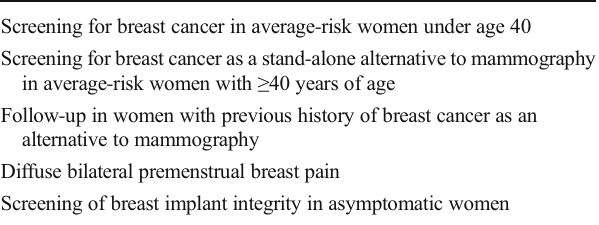
Inappropriate indications for breast ultrasound Screening for breast cancer in average-risk women under age 40 Screening for breast cancer as a stand-alone alternative to mammography in average-risk women with ≥ 40 years of age Follow-up in women with previous history of breast cancer as an alternative to mammography Diffuse bilateral premenstrual breast pain Screening of breast implant integrity in asymptomatic